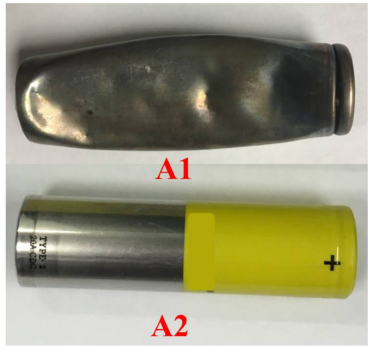
Figure 9. Photo of the exploded (A1) and backup (A2) e-cigarette cylindrical 18650